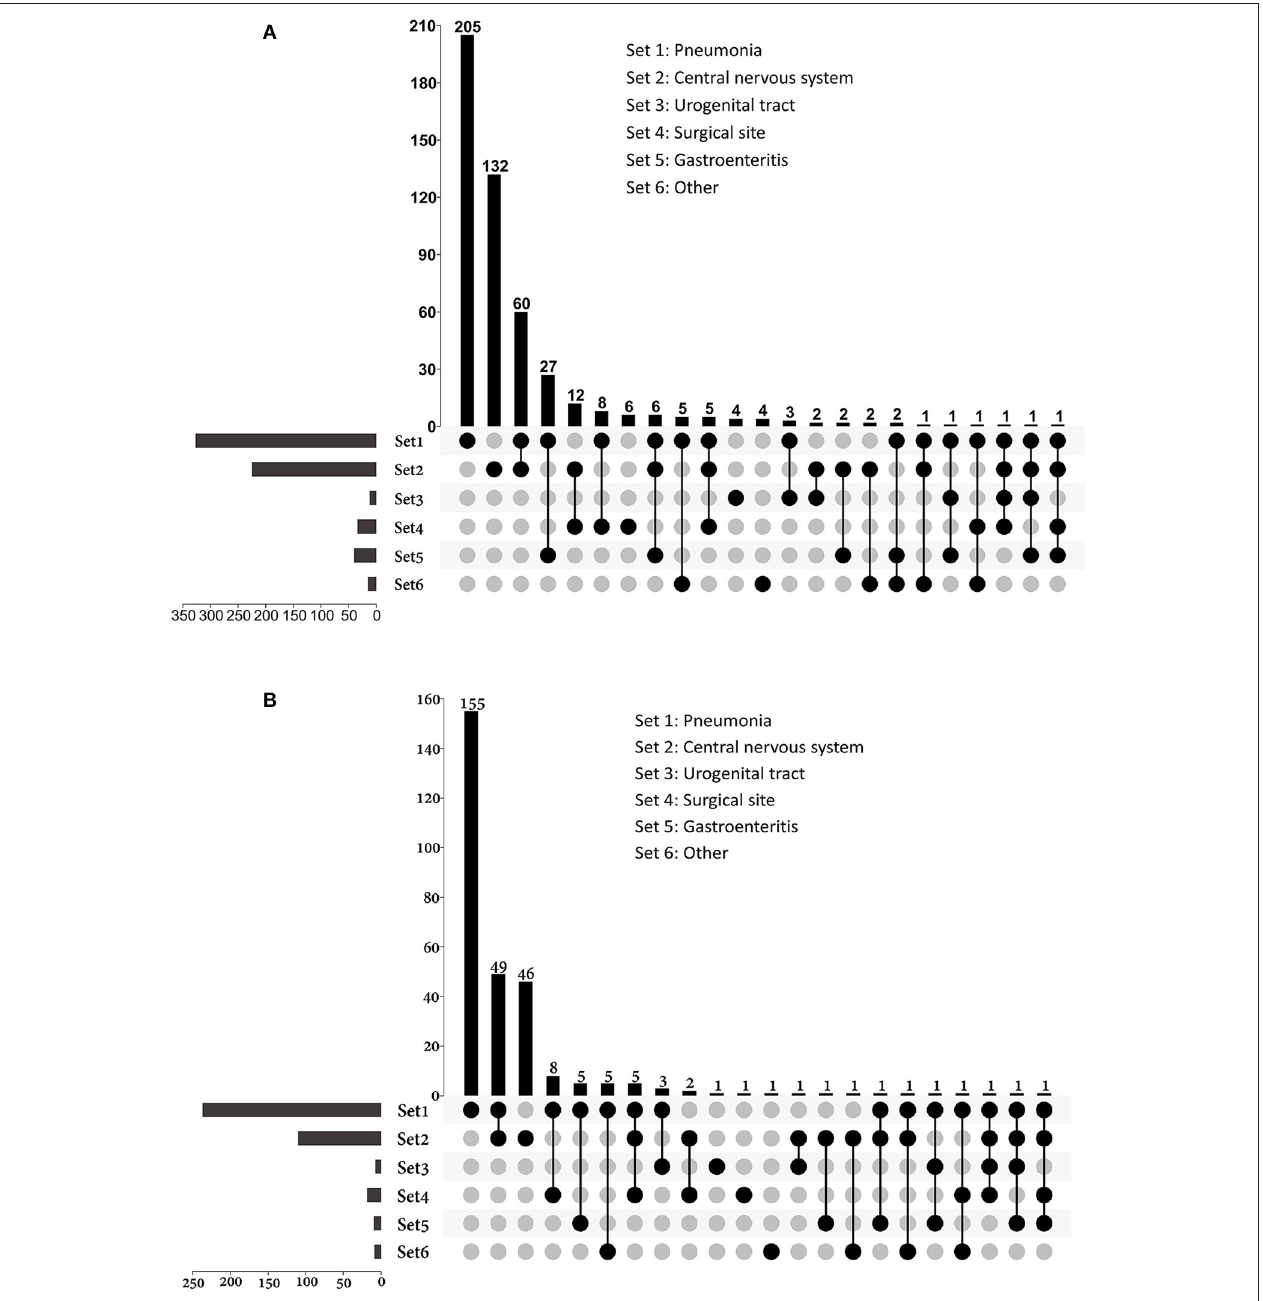
FIGURE 3 | UpSet plots depicting the distribution of infection sites in patients with (A) infection and (B) sepsis. The total numbers of patients with different sites of infections were represented on the left barplot. For patients had multi-site infections, the distributions of their infection sites were represented by the bottom plot, and the numbers of patients were shown on the top barplot. Other sources of infection and sepsis included bloodstream infection, skin and soft tissue infection, intrathoracic infection, parotiditis, osteomyelitis and upper respiratory tract infection.